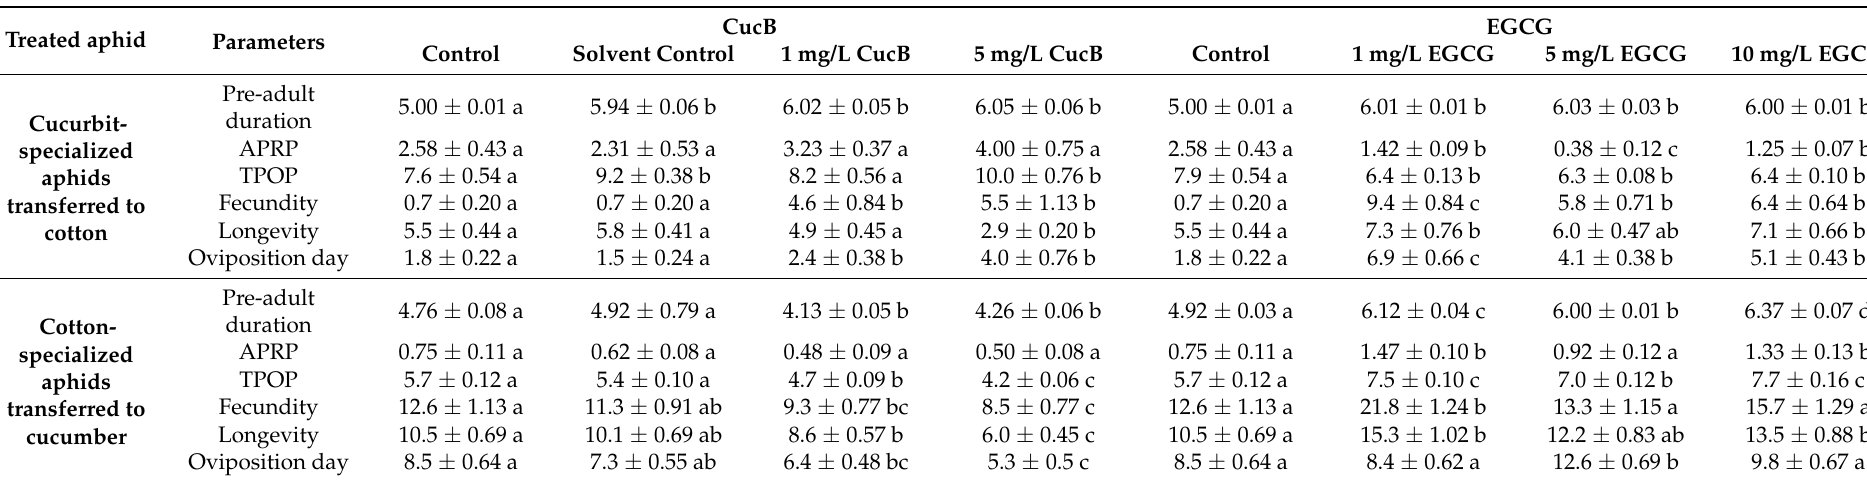
Table 3. Effect of CucB and EGCG on fecundity, longevity, adult pre-reproductive period (APRP), total pre-reproductive period (TPRP), and mean and oviposition day of Aphis gossypii on nonhost plant.